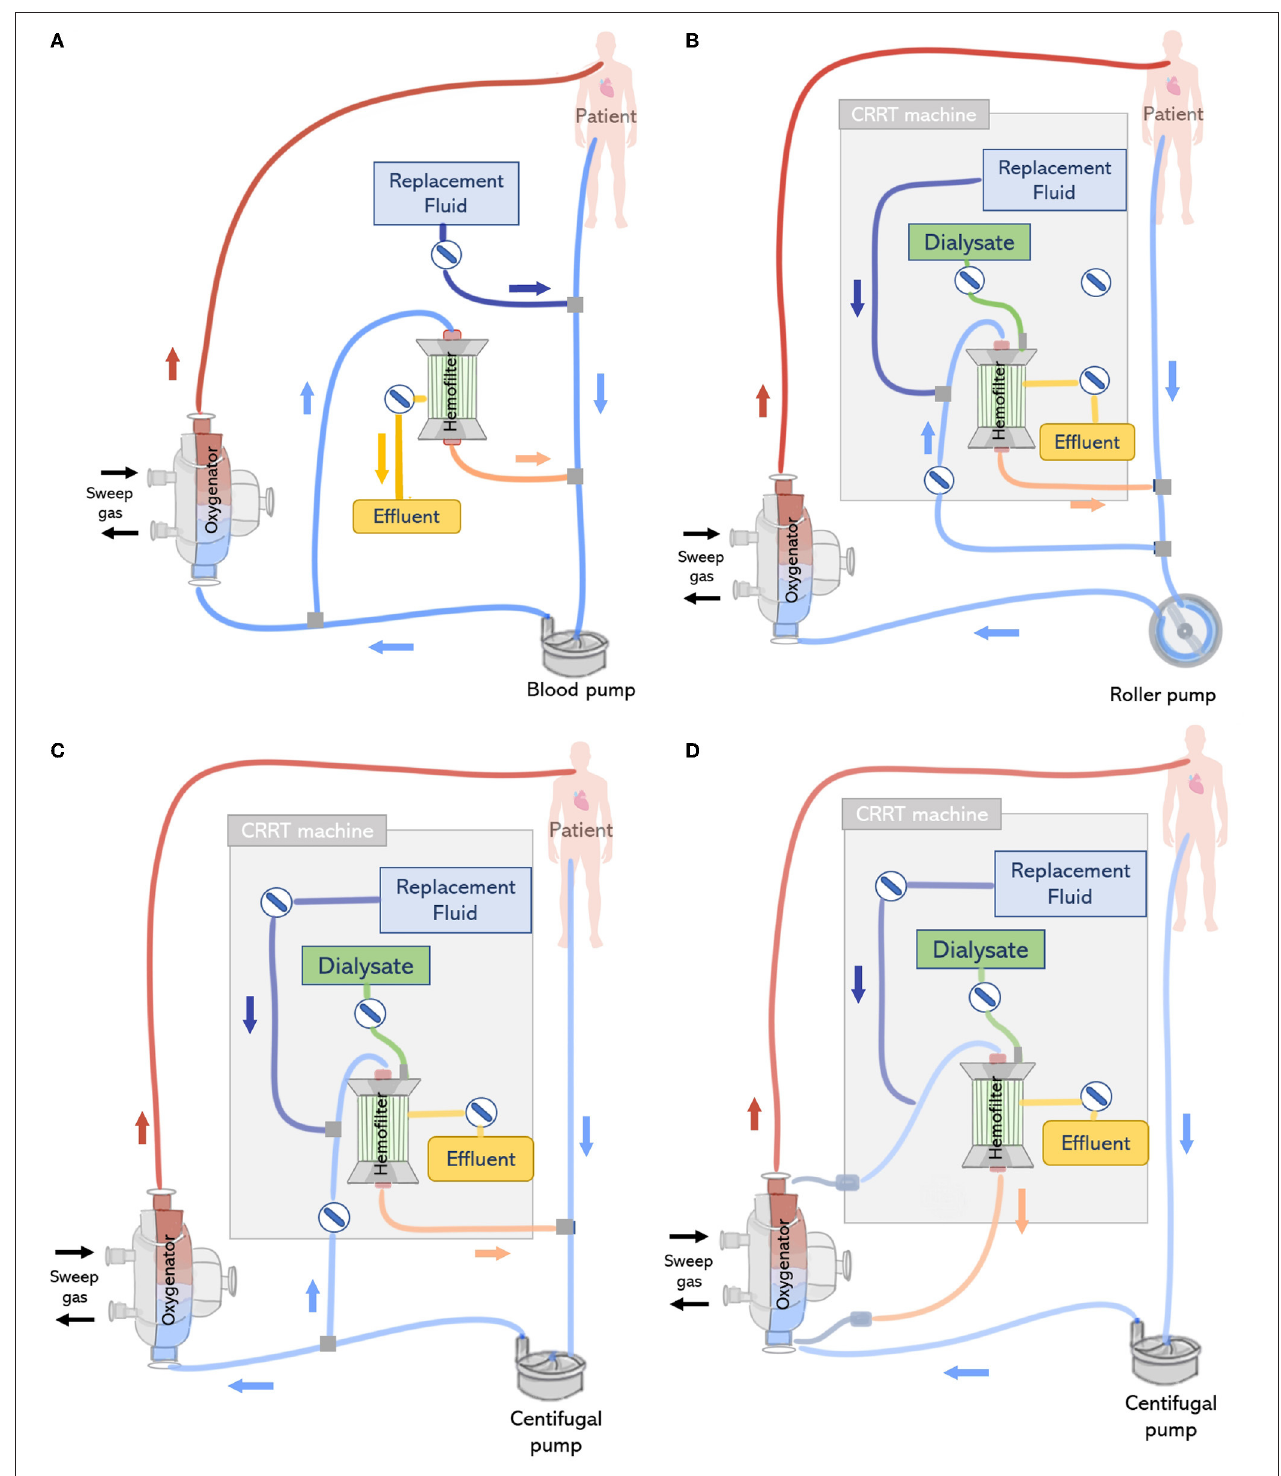
FIGURE 7 | (Top left) (A) In-line connection of a hemofilter to the ECMO circuit. The hemofilter is connected to the high-pressure part of the ECMO circuit after the blood pump or post oxygenator. (Top right) (B) Connection of a CRRT machine to the ECMO circuit with a roller pump. The inlet of the CRRT circuit is connected to the ECMO circuit before the pump and CRRT outlet is returned before the pump and ECMO bladder or directly to the bladder. (Bottom left) (C) Connection of a CRRT machine to the ECMO circuit with a centrifugal pump. The inlet access of the CRRT machine is connected to the high-pressure line of the ECMO circuit and the CRRT outlet is returned before the pump. (Bottom right) (D) Connecting the CRRT machine to the ECMO circuit via existing access points pre-oxygenator and post-oxygenator.